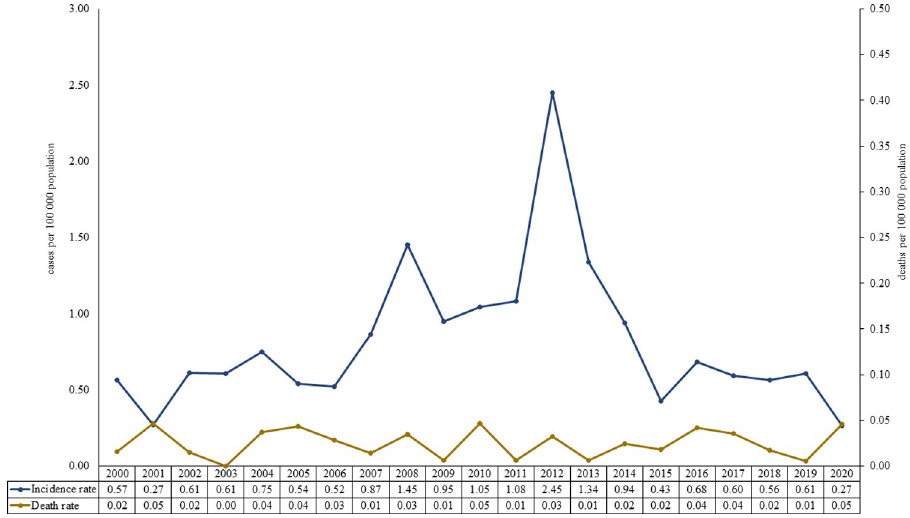
Fig 2. Annual incidence and mortality of leptospirosis (2000–2020). In the figure, the cases per 100,000 population are plotted on the ordinate as a function of the years on the abscissa for the incidence rate (blue) and the death rate (yellow). The box with the key to the colors at the lower left also marks the respective data for each year in the two rows underneath the abscissa .